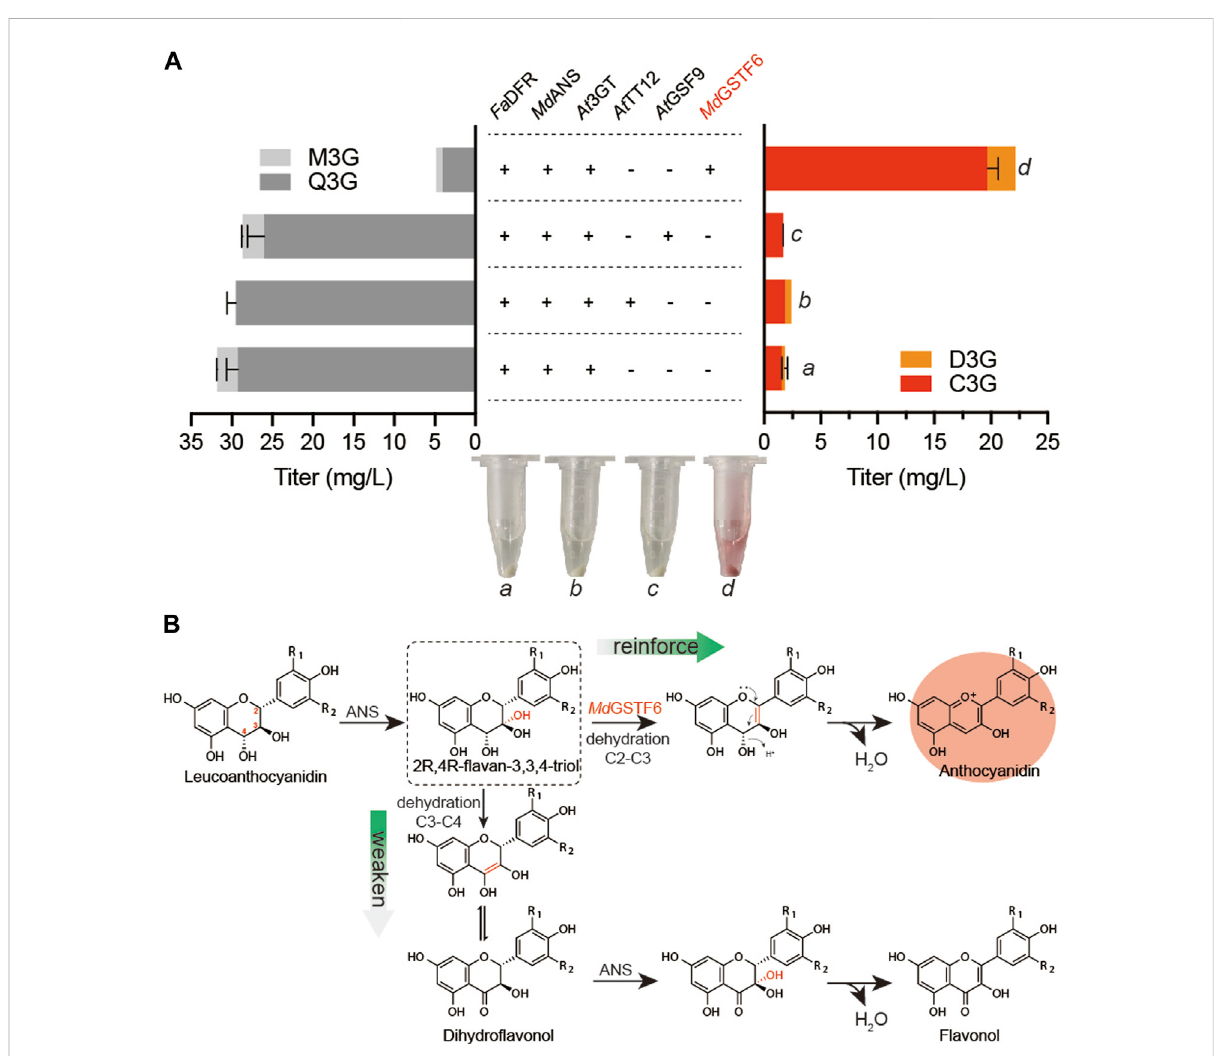
FIGURE 2 Metabolic engineering strategies for anthocyanin production (A) At TT12, At GSF9, and Md GSTF6 promoted by P INO1 co-expressed with Fa DFR and Md ANS promoted by P TDH1 and P GAL10 in the BA-01 strain with the pY26-TEF-GPD. The “ a, ” “ b, ” “ c, ” and “ d ” are the fermentation broth